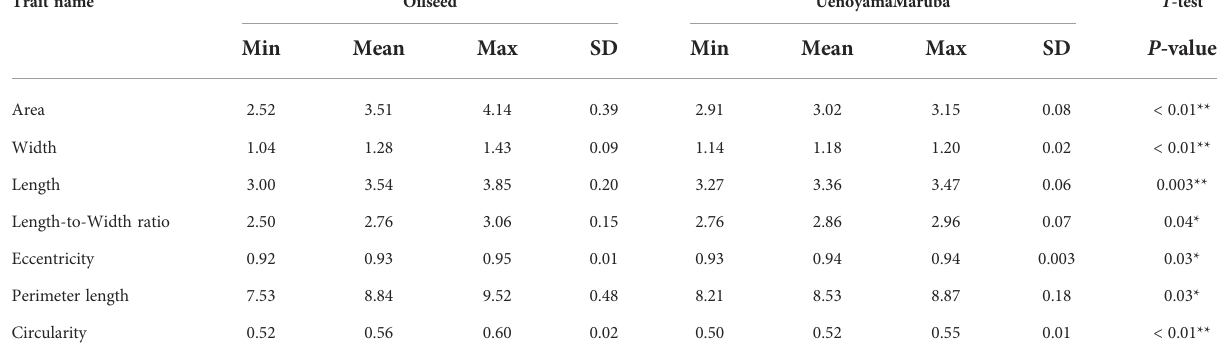
TABLE 2 Phenotypic traits measured in the parental